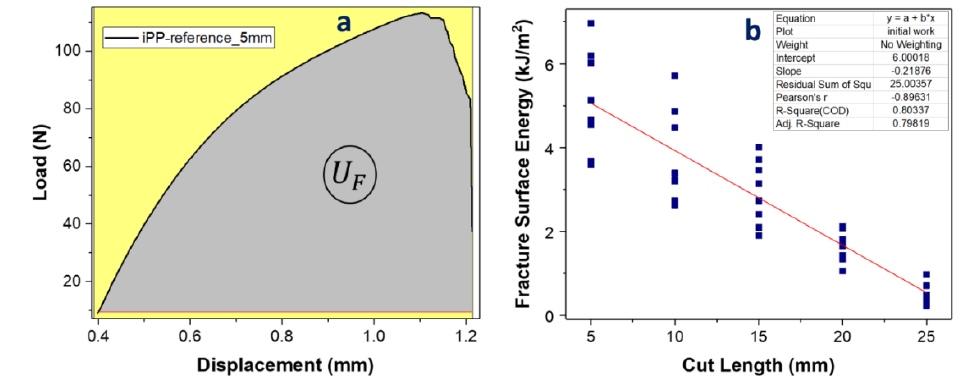
Figure 4. ( a ) Typical load displacement denoting the area of U F for the complete fracture and ( b ) a plot of the total fracture surface energy vs. the cut length, presenting the linear regression fit from which γ F was calculated (for iPP-reference).